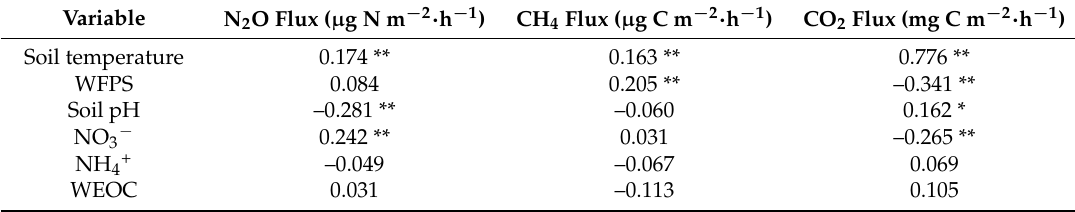
Table 4. Linear regressions (Pearson’s correlation coefficients) for the relationship between greenhouse gas fluxes and environmental variables (experiments 1 and 2